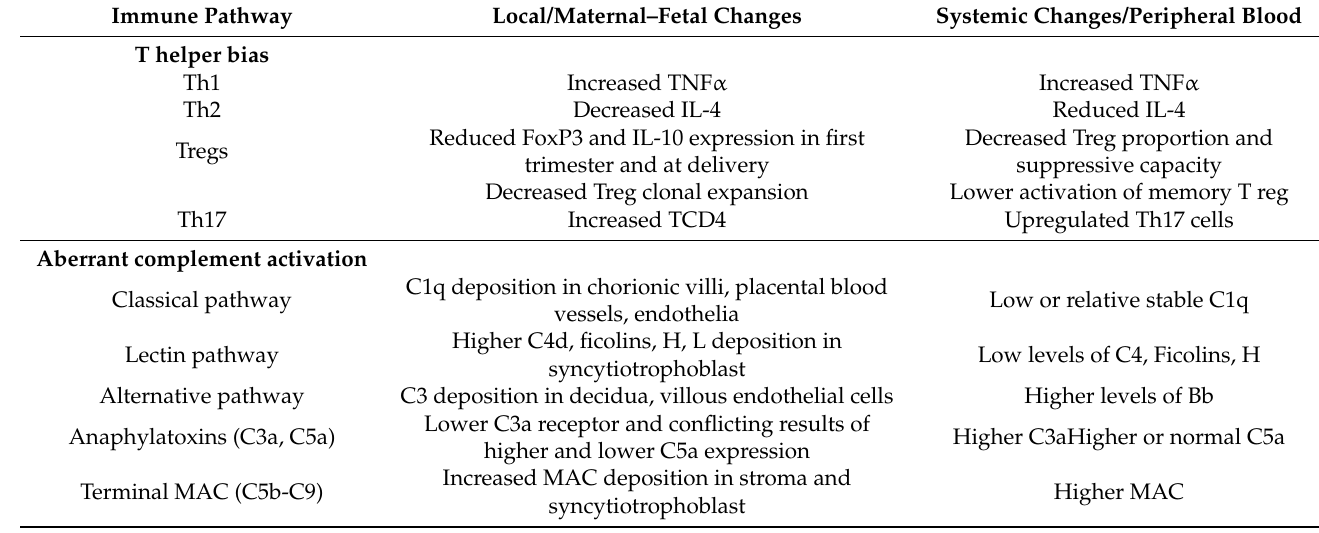
Table 1. Immunological alterations in